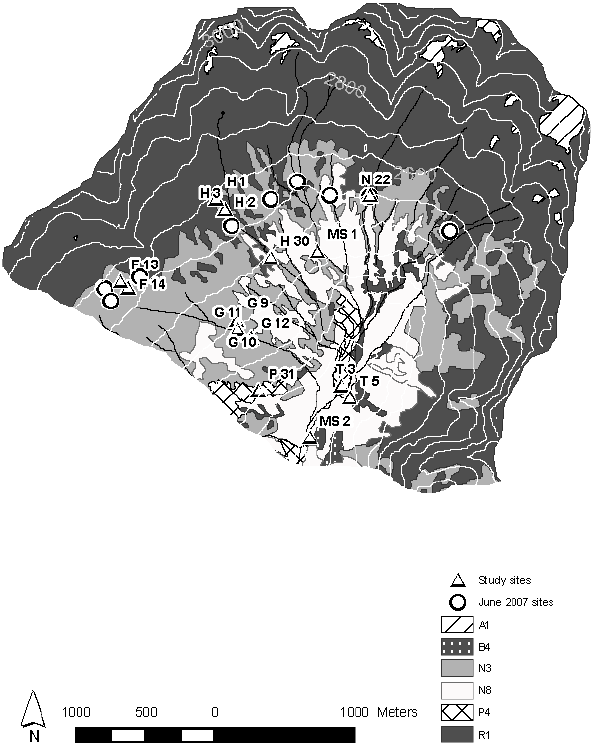
Fig. 1. Map of the of the Masino stream upper basin, indi- cating the location of the sampling sites and the land cover categories (A1=Glaciers and snowfields, B4=Coniferous forest, N3=Vegetation on rocks and rock debris, N8=Shrub vegetation, P4=Meadow vegetation, R1=Rock debris and